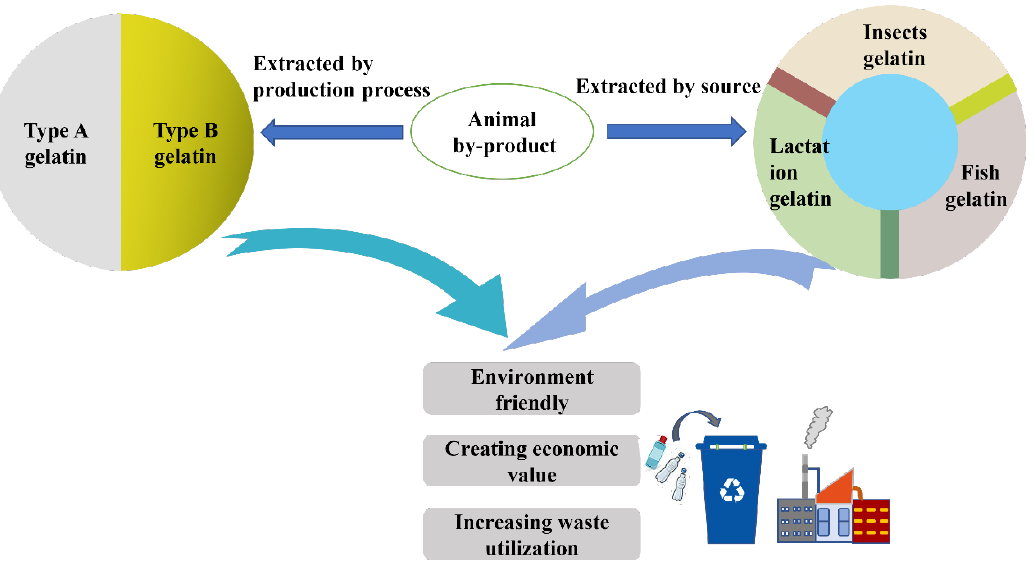
Figure 3. Schematic representation to extract gelatin according to different methods and sources and realize circulation for gelatin films.